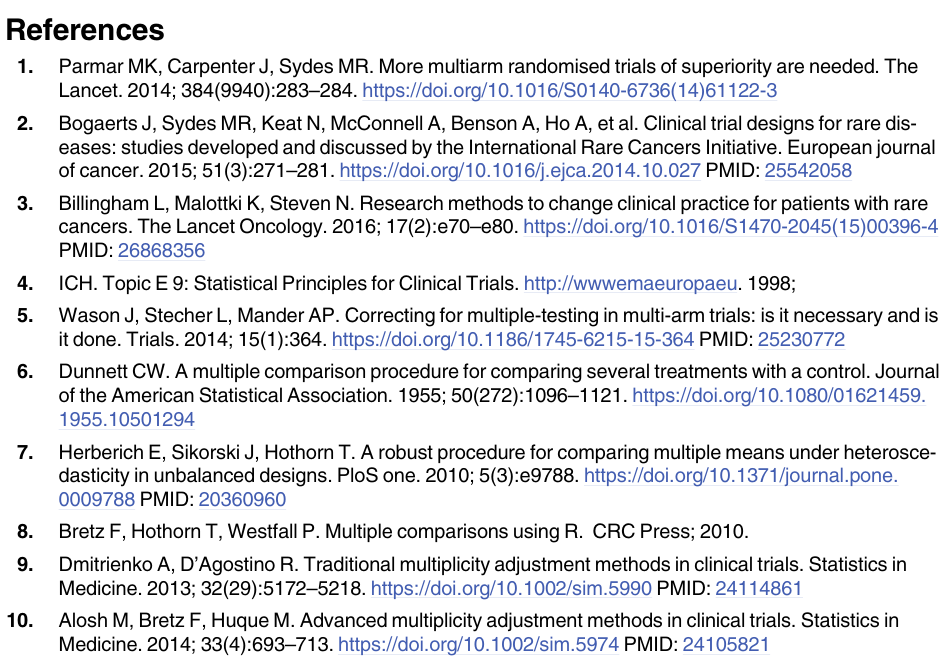
S1 Example. Hypothetical example of the two-step